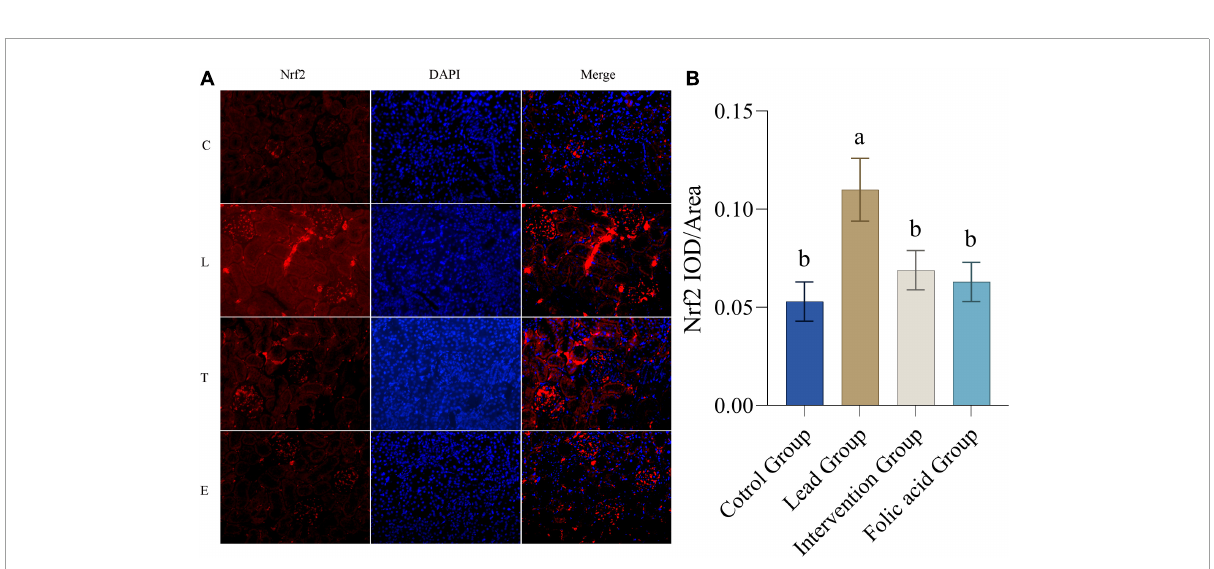
FIGURE3 Effect of folic acid on the expression of nuclear factor erythroid 2-related factor 2 (Nrf2) protein in the kidney of lead exposed rats. (A) Immunofluorescence results of Nrf2 protein expression (200 × ). (B) The expression level of Nrf2 protein is represented by the average integrated optical density value ( n = 6). C: control group; L: lead-exposed group; T: intervention group; E: folic acid group. Data were presented as mean ± SD. Different superscript letters indicate differences ( P <